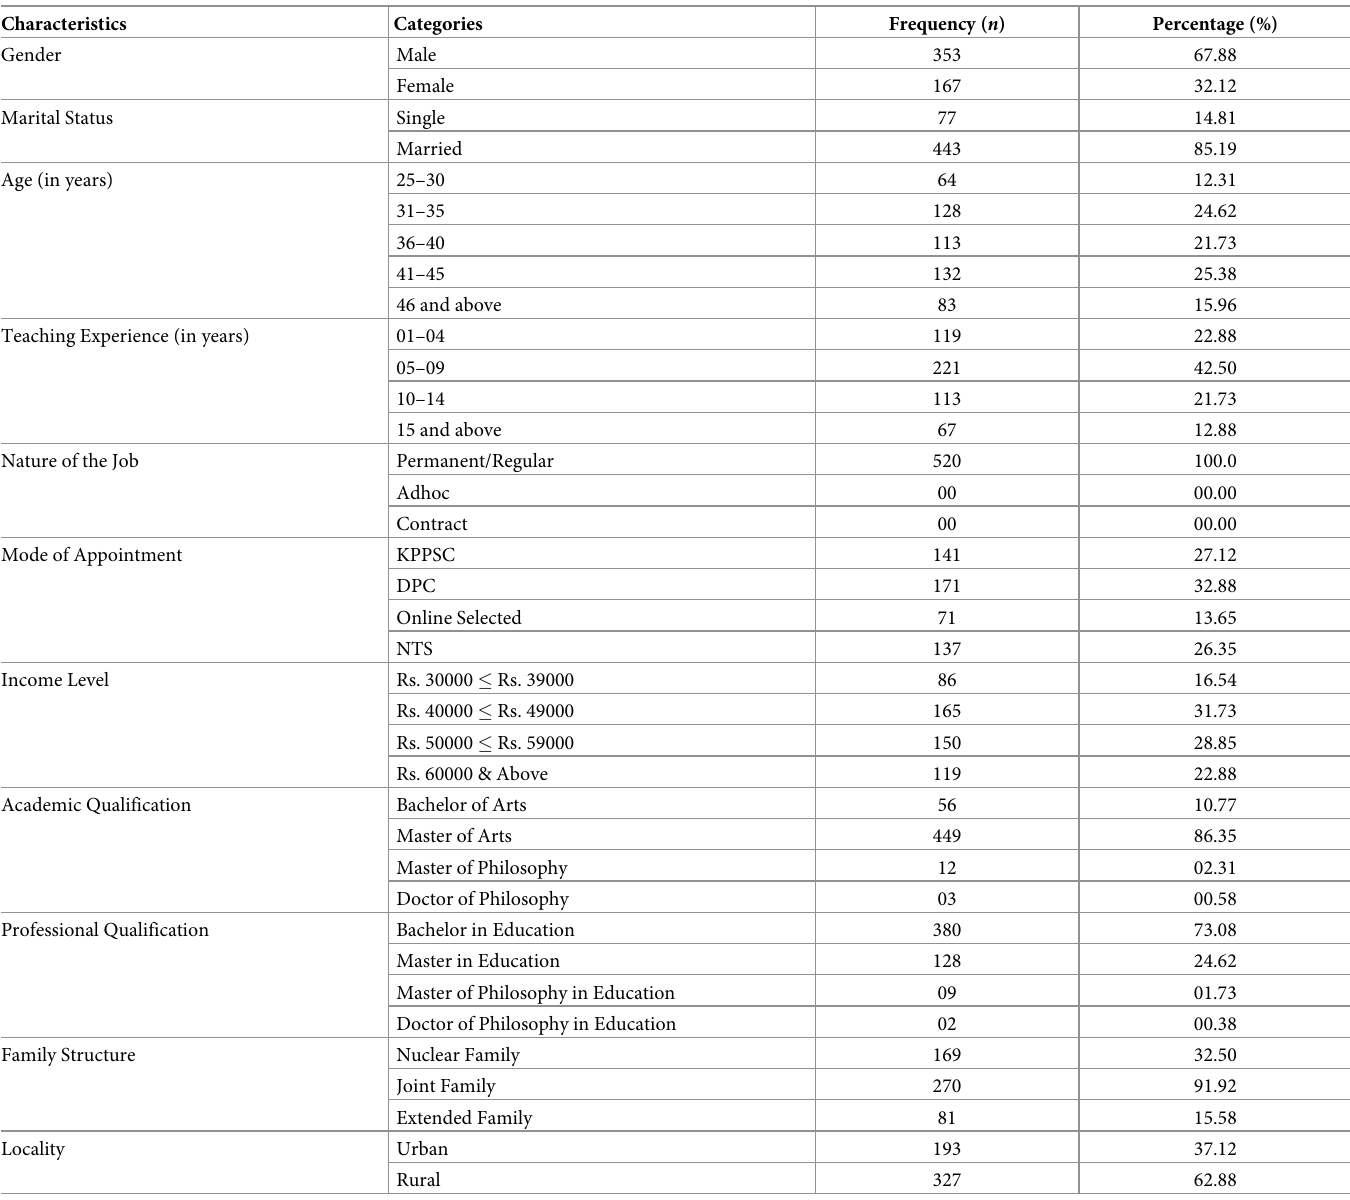
Table 3. Participants’ demographic